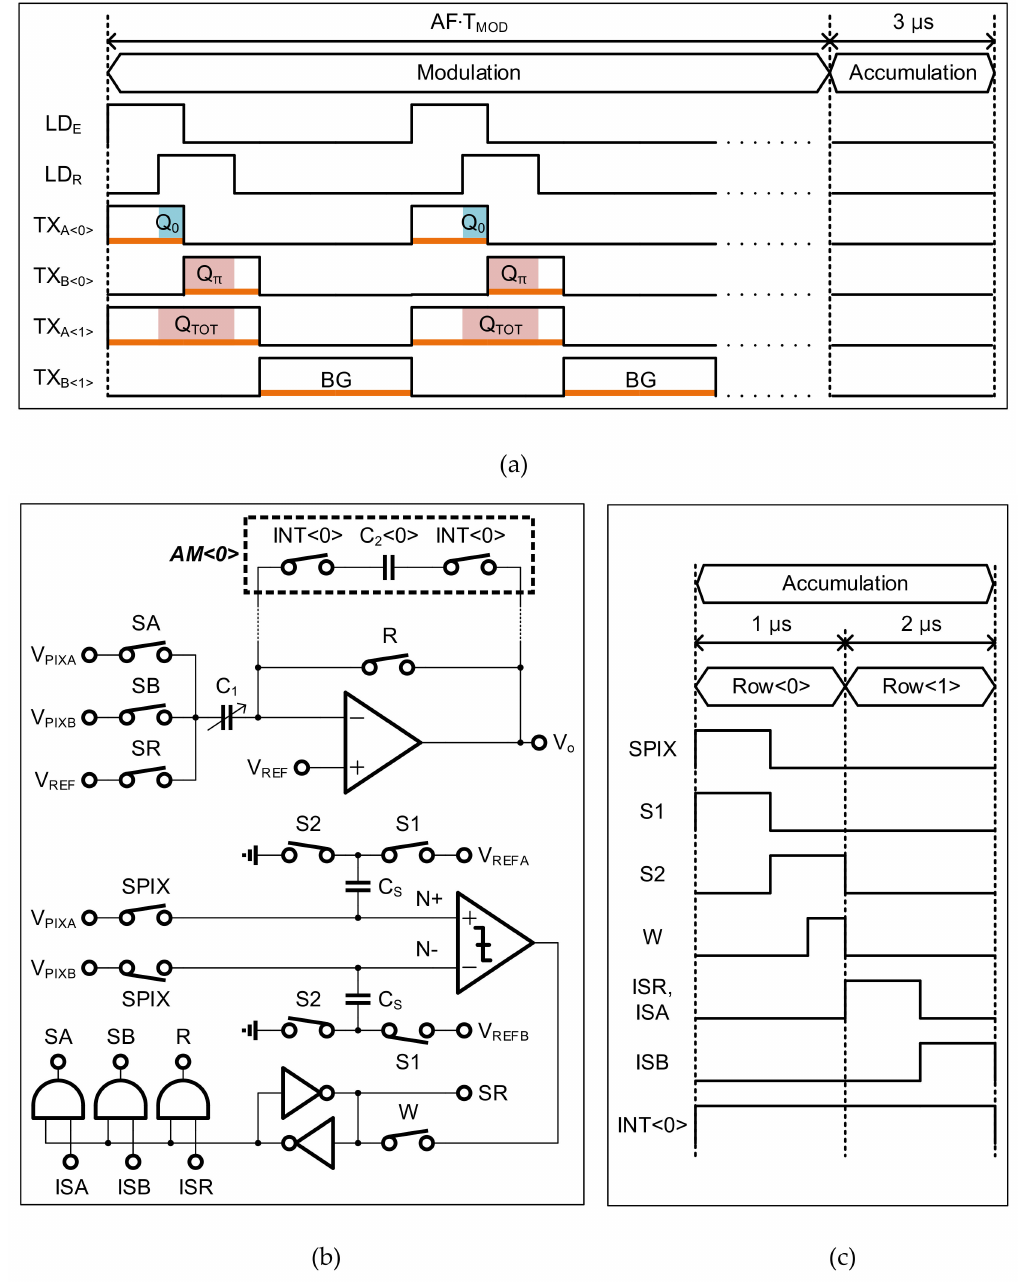
Figure 6. The proposed column-parallel accumulator (CA) circuit and the operation in one T SUB : ( a ) timing diagram of one T SUB ; ( b ) circuit schematic; ( c ) timing diagram in one accumulation